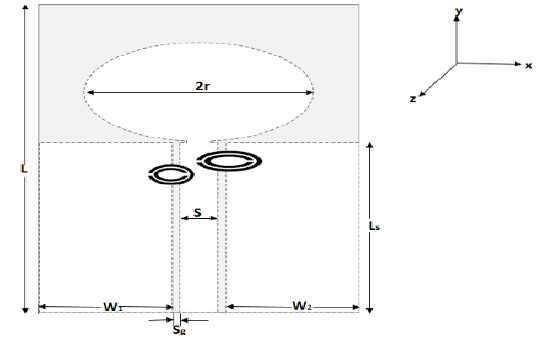
Figure 3: The proposed antenna with two different